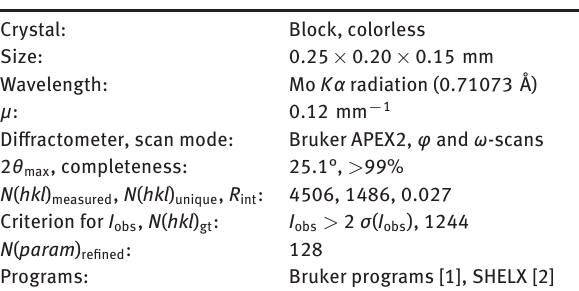
Table 1: Data collection and handling.